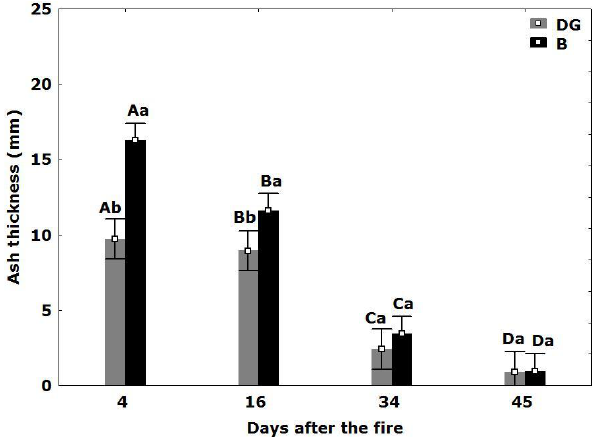
Fig. 7. Evolution of mean ash thickness from the grid plot in the post-fire period (bars show 95% confidence intervals). Different letters indicate significant differences ( p< 0 . 05) between dates (capital letters) and ash types (low-case letters). DG, dark grey ashes; B, black ashes; LG, light grey ashes.